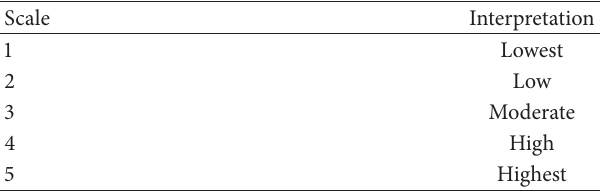
Table 1: Scale indicating relative values for cutting fluid properties.